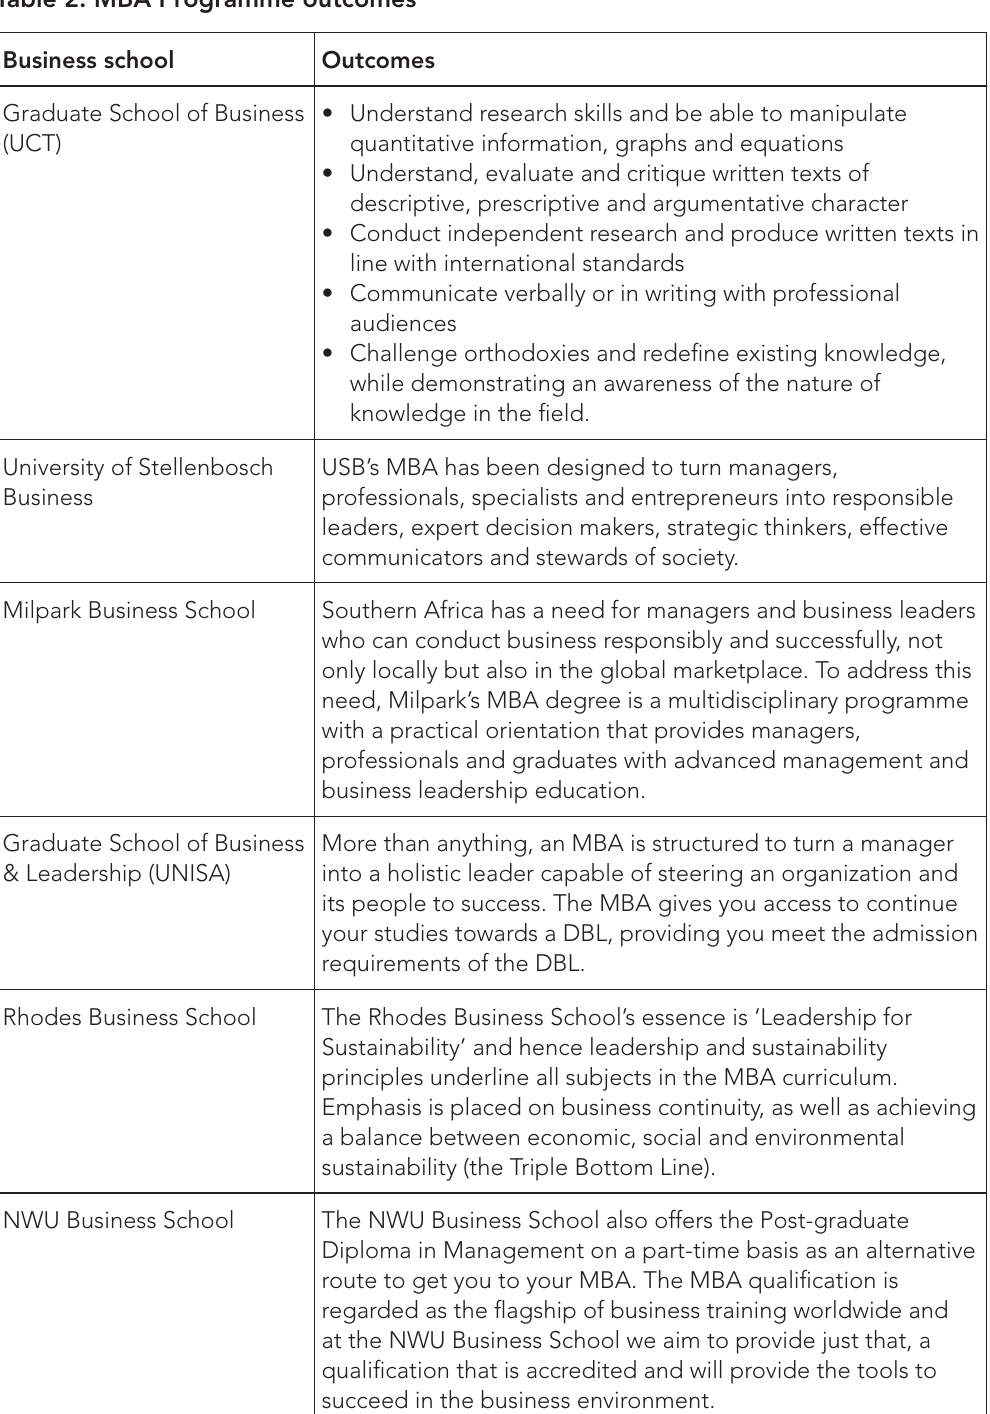
Table 2: MBA Programme